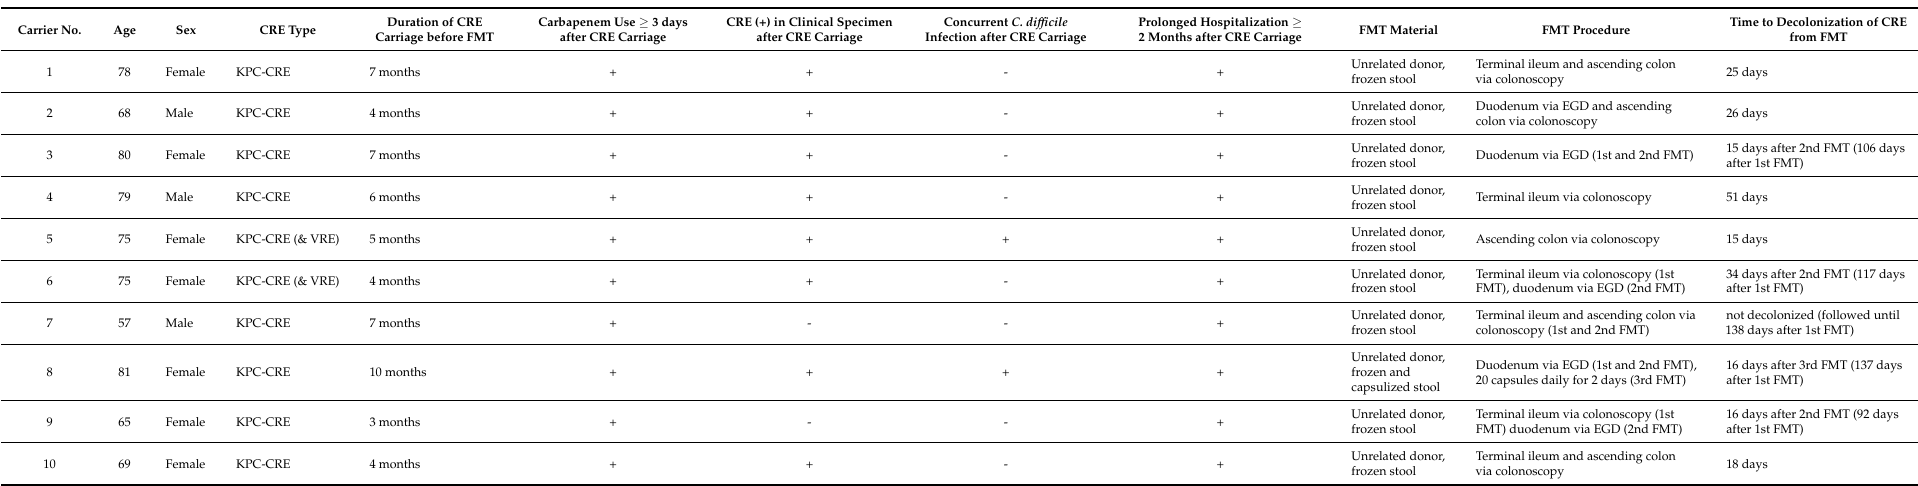
Table 1. Summary of Characteristics of Selected CRE